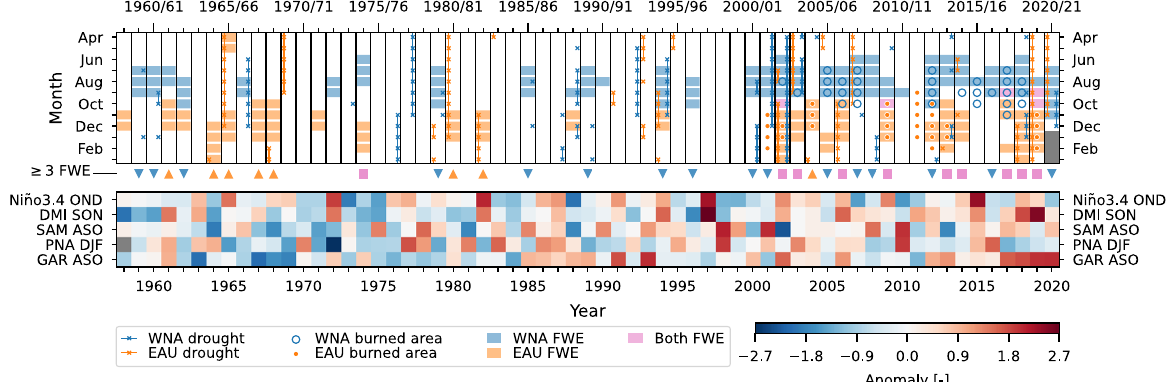
Fig. 6 Fire weather, drought and burned area in western North America (WNA) and eastern Australia (EAU), and related climate modes. Top Fire weather events, FWD r (cid:1) σ < μ P r events, P r P r 12 (vertical lines with cross markers). Years in which there were at least three 12 12 marked with a triangle or square below. WNA results are in blue, EAU results are in orange, and concurrent results are in pink. Bottom The Ni ~ n o3.4 index, the dipole mode index (DMI), the southern annular mode index (SAM), the Paci fi c-North America pattern index (PNA) and the Gulf of Alaska ridge index (GAR), averaged over the three months indicated by the last three